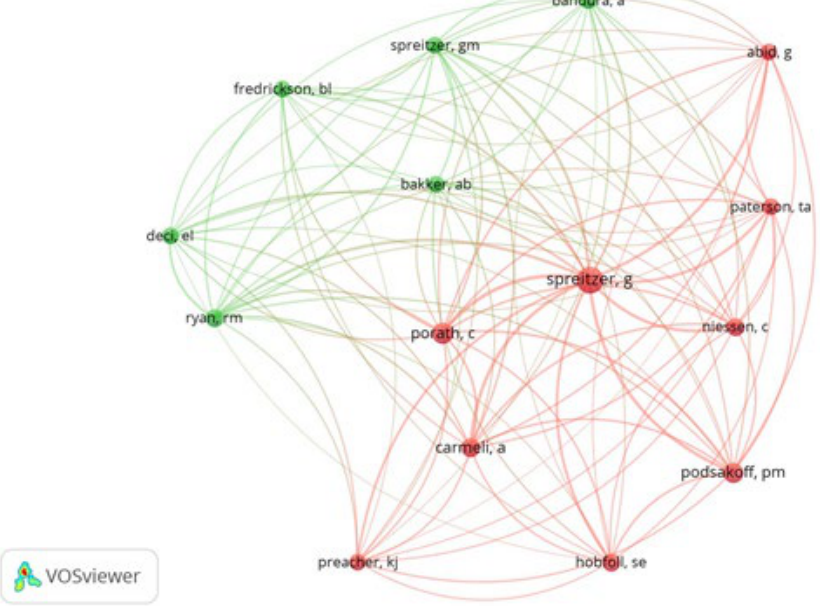
Figure 10. Map of co-citation of cited authors that show how the networks are grouped. Table 8. Bibliographic coupling of